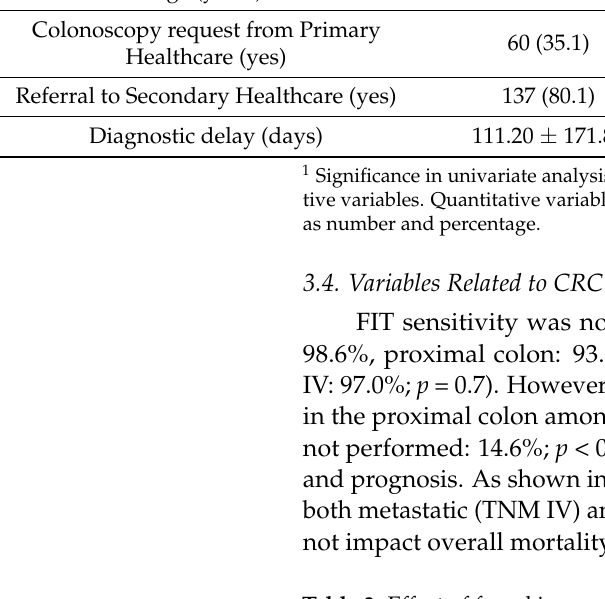
Table 3. Effect of faecal immunochemical test on colorectal cancer location, stage, and prognosis. FIT Not Performed (n =